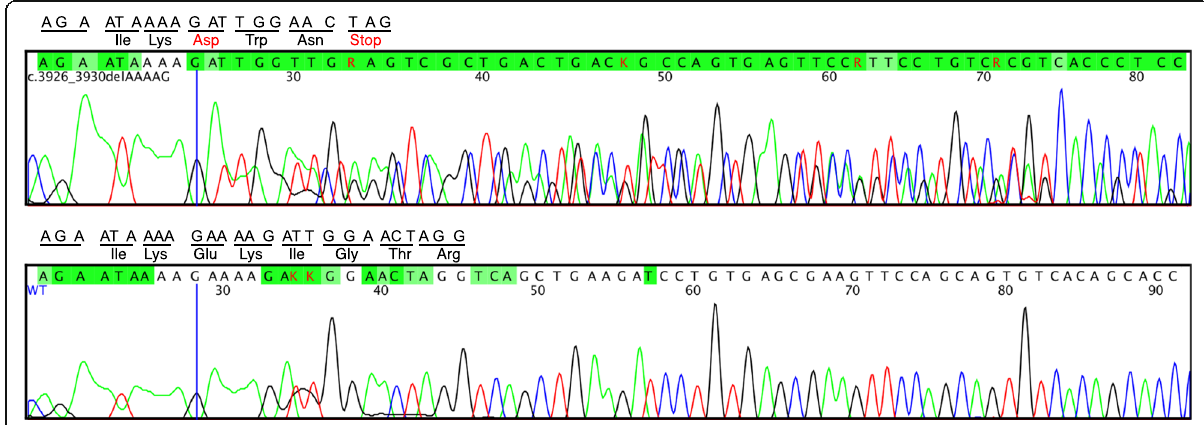
Fig. 3 Validation of the deletion in affected members using Sanger sequencing. (Top) The heterozygous deletion c.3927_3931delAAAGA in proband II-2: the deletion causes a frameshift and creates a Stop codon downstream. (Bottom) The complete sequence in unaffected members. The blue vertical line represents the last base before